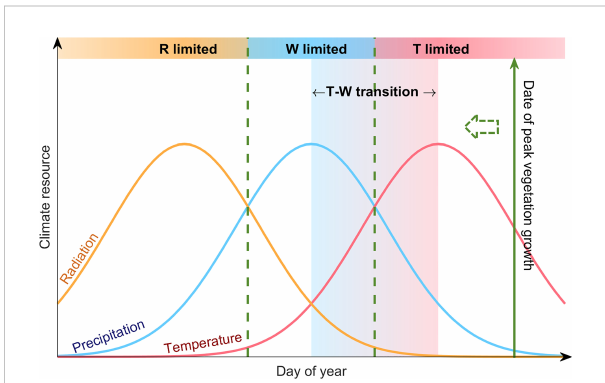
FIGURE 1 Conceptual illustration of the analyzing framework based on “ law of minimum ” . The curves show the standardized seasonal cycle of radiation (orange), precipitation (blue) and temperature (red) over the Tibetan Plateau. The solid green line shows the date of peak vegetation growth. The shadings mark different cases for climate constrains on vegetation growth. For instance, when the date of peak vegetation growth occurs around the temperature peak, it means that the most abundant water availability did not lead to vegetation growth reaching its peak, until adequate heat supports peak vegetation growth, indicating that the ecosystem is thermal- limited (T-limited). Similarly, an ecosystem with the date of peak vegetation growth close to the precipitation peak would be a water- limited ecosystem (W-limited), and we de fi ne the case when the date of peak vegetation growth occurs between the precipitation and temperature peaks as a transition state between thermal- and water-limited ecosystem (T-W